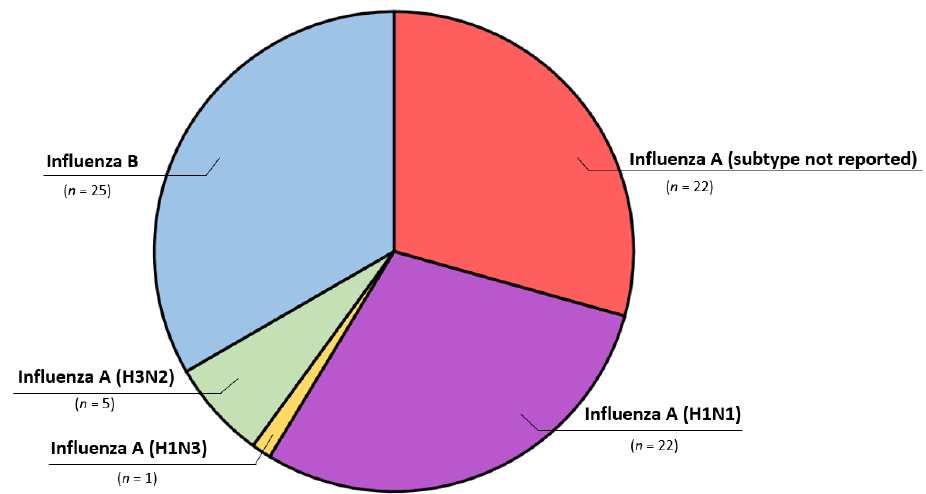
Figure 3. Influenza type and subtype distribution.